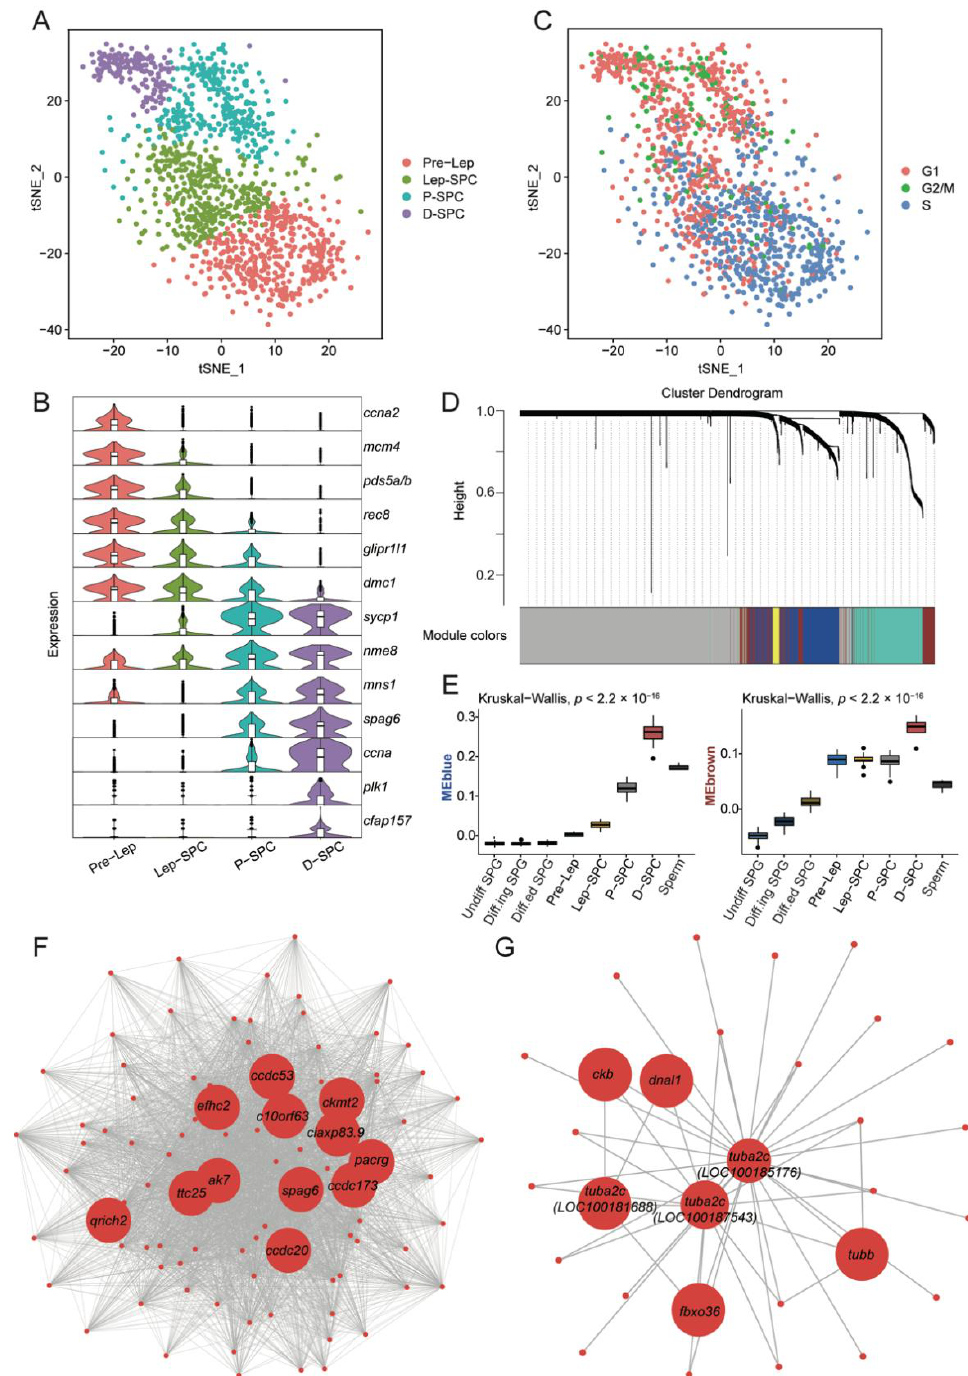
Figure 3. Identification of four meiotic cell populations in C. intestinalis . ( A ) t-SNE of spermatocyte re-clustering. Different colors correspond to 4 different stages of spermatocyte subsets. Pre-LEP: preleptotene spermatocytes; Lep-SPC: leptotene spermatocytes; P-SPC: pachytene spermatocytes; D-SPC: diplotene spermatocytes. ( B ) Vlnplot of the normalized expression of meiotic marker genes. ( C ) t-SNE plot showing the cell cycle status of spermatocytes. ( D ) The clustering dendrogram of the weighted gene coexpression network. The resulting modules are depicted in different colors: blue, turquoise, yellow, brown, and gray. ( E ) Boxplot showing the correlation of the blue module and brown module with all germ-cell types. ( F ) Interactions of the top 100 genes in the blue module, with the top 12 hub genes highlighted. ( G ) Interactions of all genes in brown module, with the top 7 hub genes highlighted.